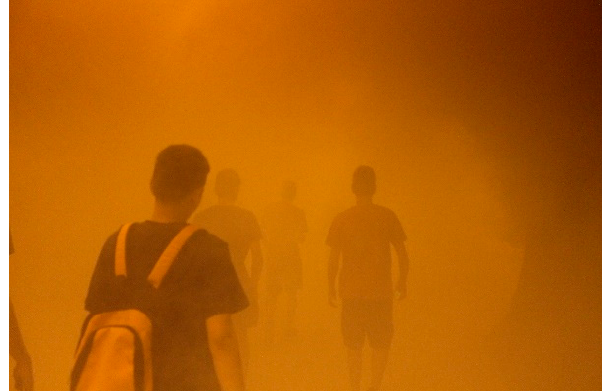
Figure 17. Visibility during evacuation in smoke environment.